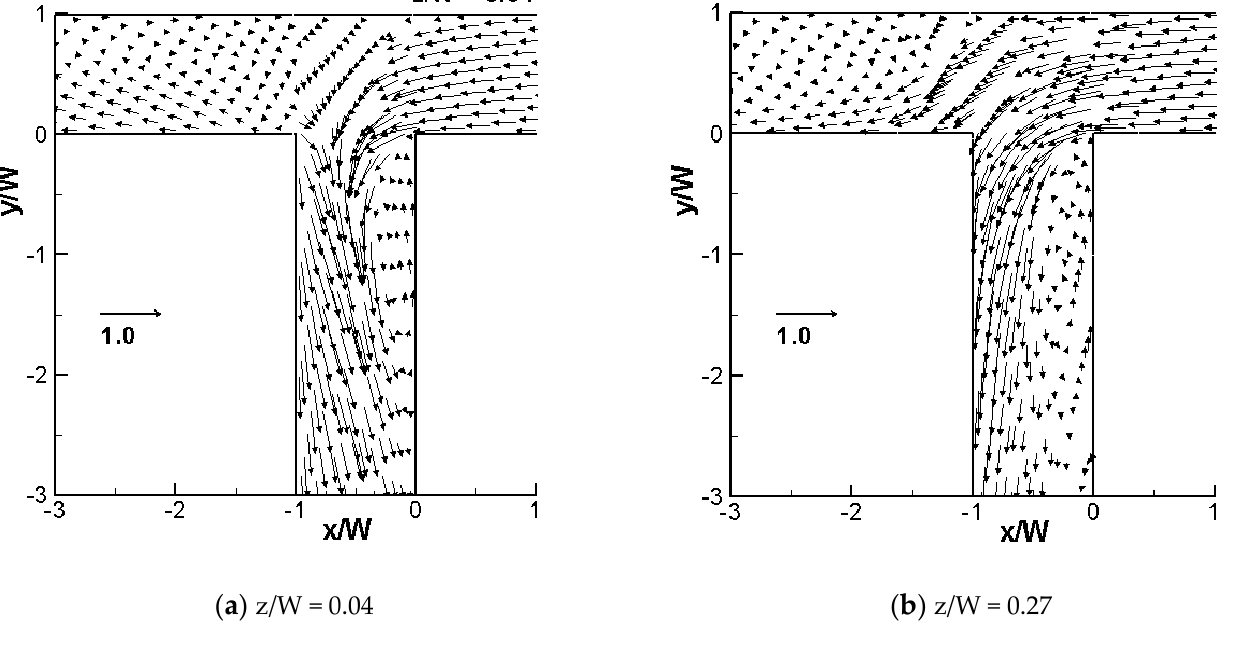
Figure 7. Velocity vector plots at two horizontal planes; figure ( a ) is near the bed and figure ( b ) is near the free surface.